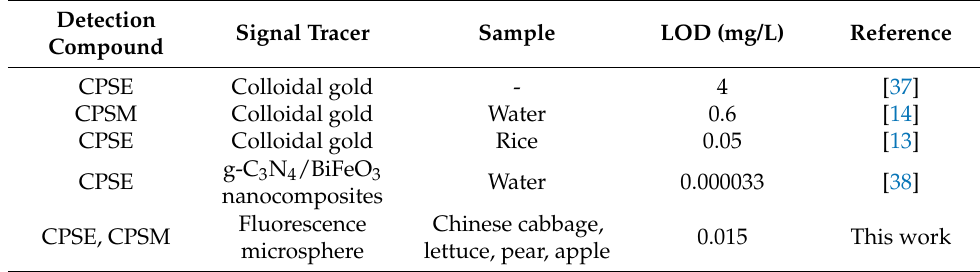
Figure 4. ( a ) Calibration curve of FICA for CPSE and CPSM. ( b ) The test results of serial concentra- tion of CPSE standard solution. ( c ) The test results of serial concentration of CPSM standard solu- tion. Table 2. Comparison of immunoassay for the detection of